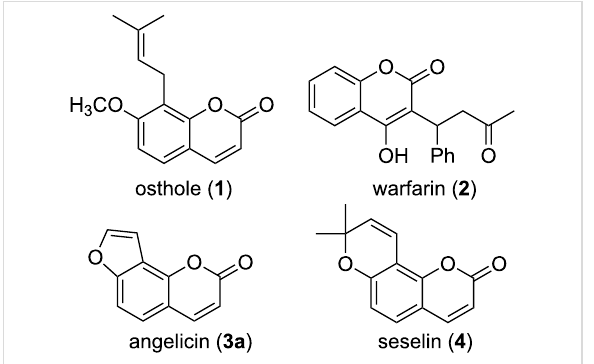
Figure 1: Illustration of coumarin taxonomy.